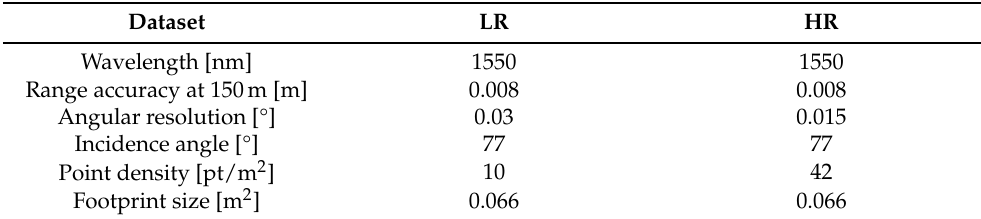
Table 1. Properties of the dataset from permanent laser scanning used in this study. LR and HR data only differ in angular resolution, point density and number of files. Incidence angle, point density and footprint size are averaged over the study area. In the present study, HR data (two files) collected during two different days have been only used for a comparison with LR data in order to investigate the effect of the resolution on the RMSH